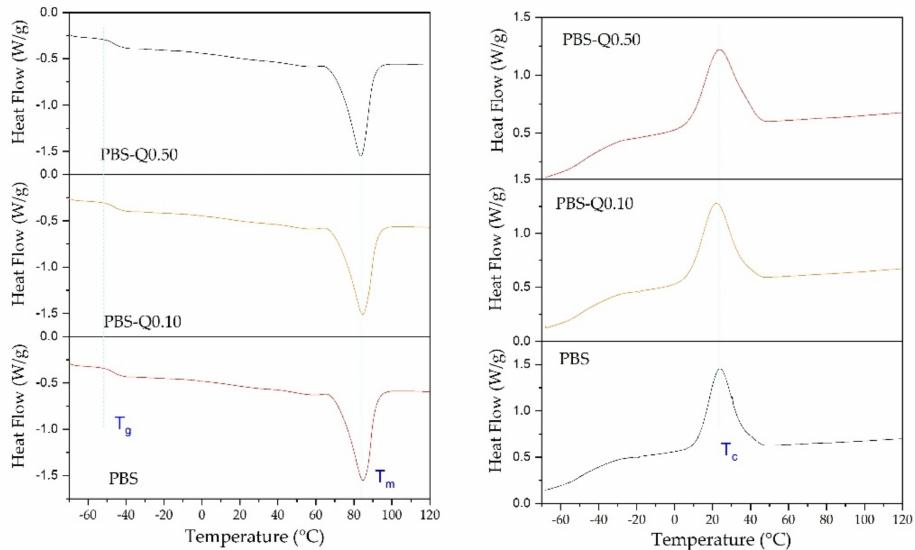
Figure 7. DSC curves for PBS-based films in heating ( left ) and cooling ( right ) run; T g —glass transition, T m —melting transition, T c —crystalization